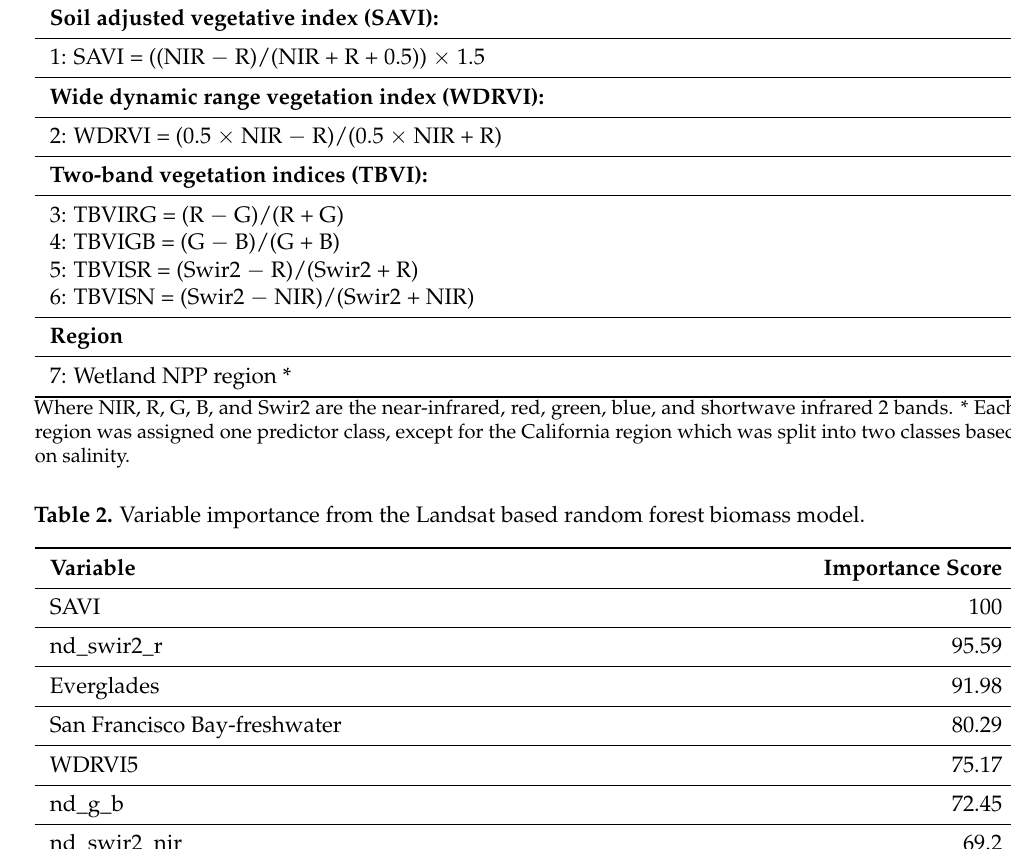
Table 1. The seven model predictors used in the random forest biomass model.